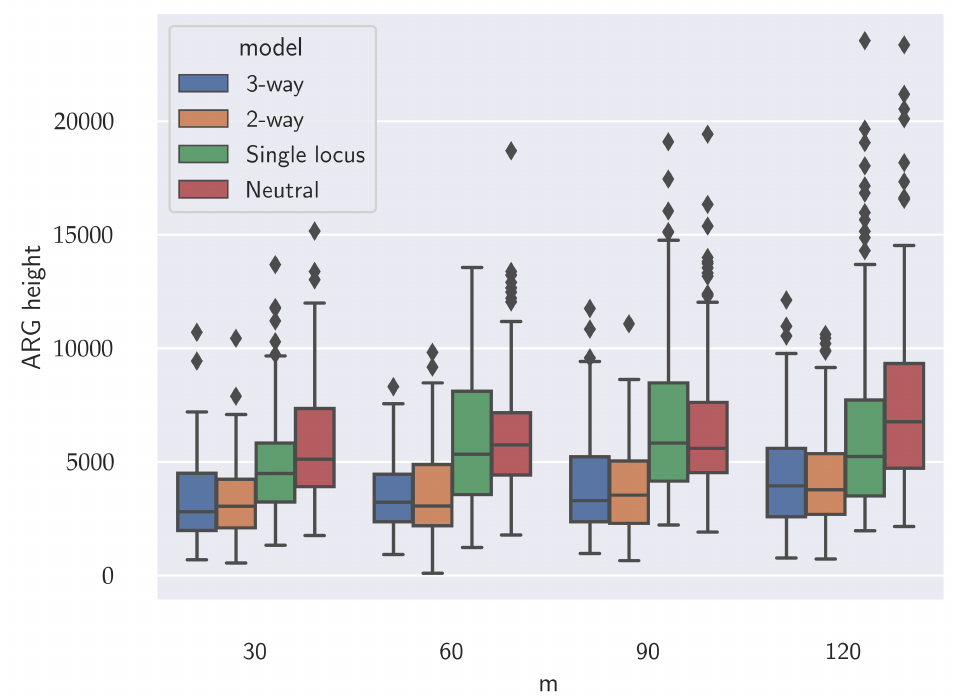
Figure A1. Comparing the height of the ARG (H) for different scenarios of selection in EpiSimRA with epistatis and recombination for N = 1000, g = 250 kbp, r = 1.0 × 10 − 8 , m = { 30,60,90,120 } , s = { 0.3,0.3,0.3 } with epistastic parameters for s i s j = 0.15 for i , j ∈ [ 1,3 ] and s 1 s 2 s 3 = 0.125. The box-and-whisker diagram summarizes the result for each m and selection scenarios such as neutral ( s = 0), single locus ( s = 0.3), epistatic interaction at two loci and three loci